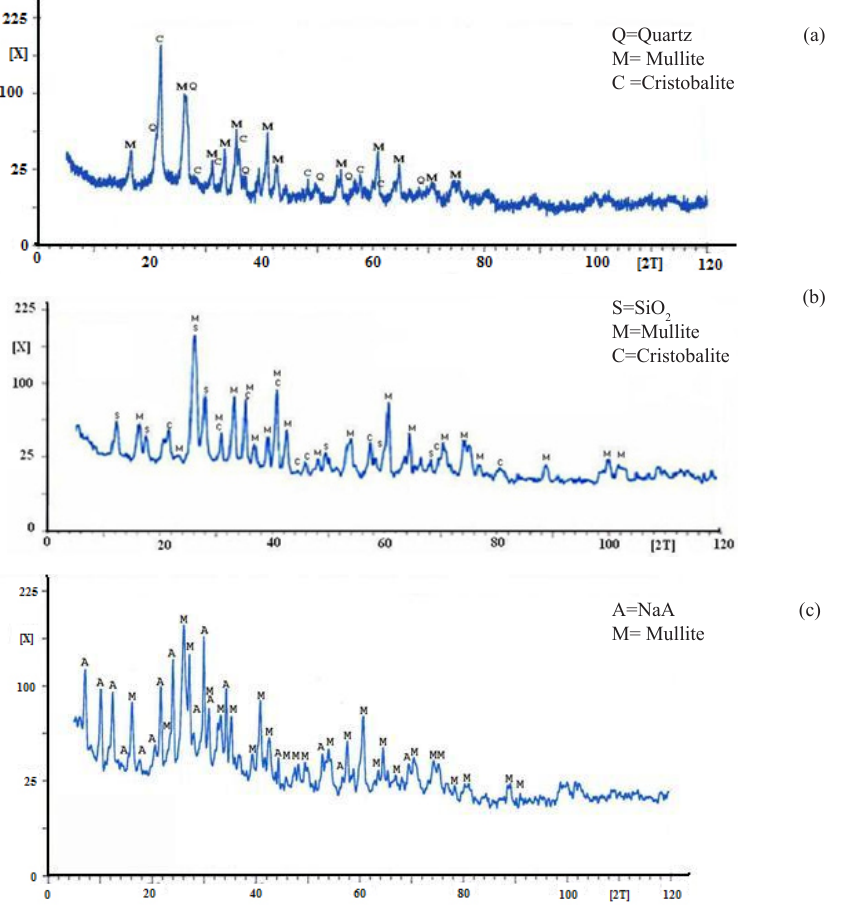
Fig. 4. XRD pattern of the membrane support a) before treatment b) after treat- ment c) seeded support after